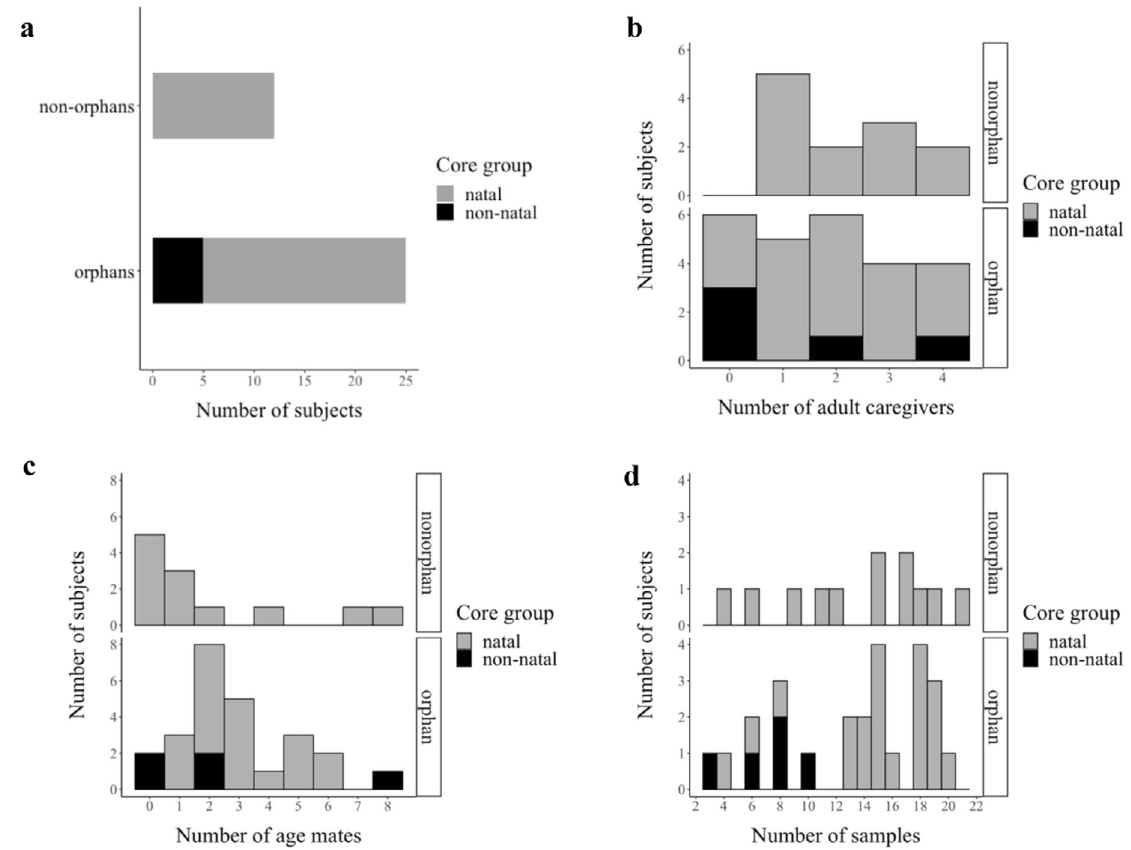
Fig. 1 Summary of sample size distributed according to orphan status, family group composition, and dung samples per individual. a Bar chart showing the number of study subjects who were orphans ( n = 25 elephants) versus nonorphans ( n = 12 elephants), colored according to whether they were with their natal ( n = 32 elephants, shaded gray) versus non-natal ( n = 5 elephants, shaded black) core group. b – d Histogram of study subjects according to the number of adult female caregivers in their core group, the number of age mates in their core group, and the number of dung samples, each also separated into orphan versus nonorphan panels and colored according to natal versus non-natal core group. Note that the nine discarded dung samples (see methods) are not included in d